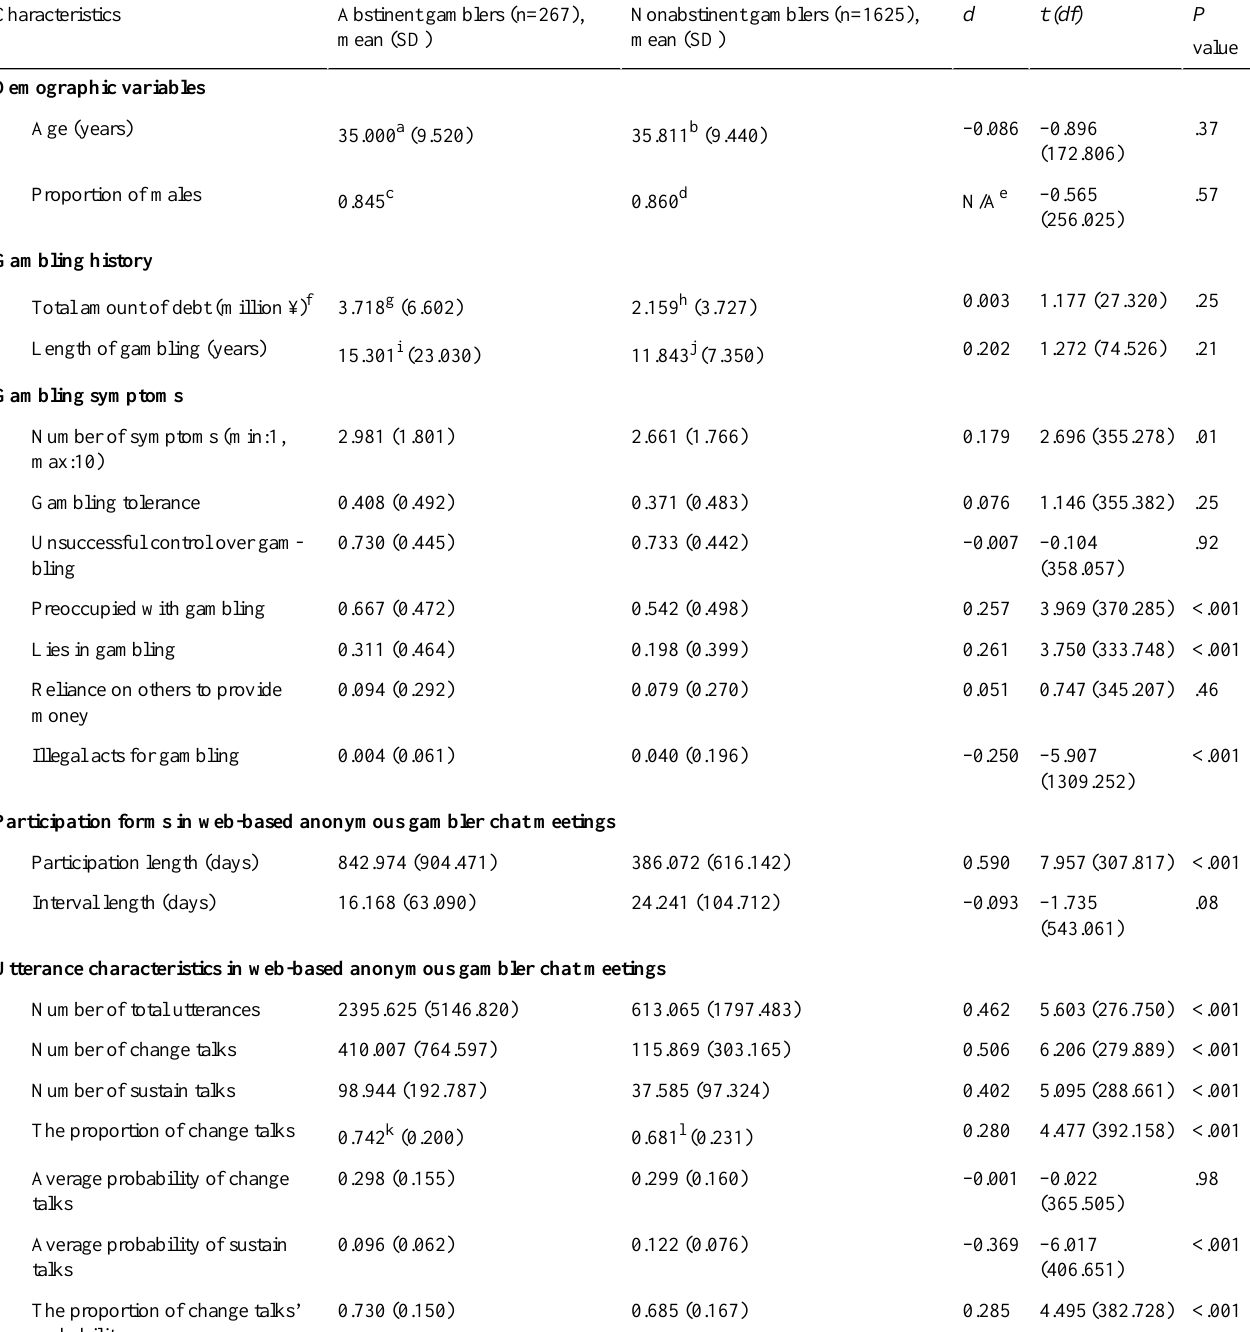
Table 1. Comparison of the demographic variables, gambling history, gambling symptoms, participation forms, and characteristics of the utterances in web-based anonymous gambler chat meetings between abstinent and nonabstinent